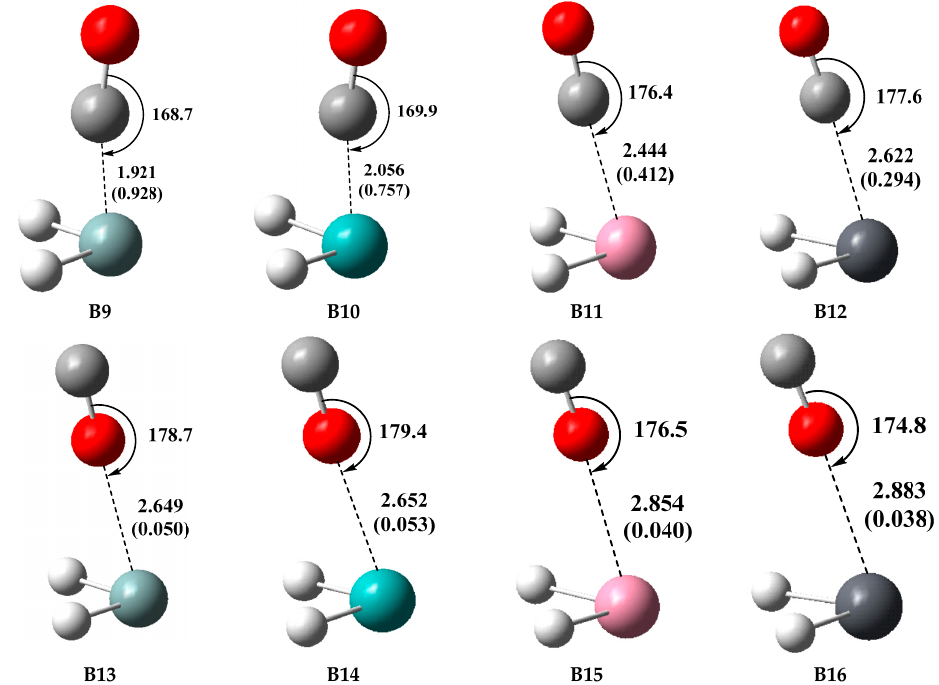
Figure 9. Optimized geometries of the type-B complexes involving CO at the MP2/aug-cc-pVDZ level, distances in Å, angles in °, and WBI values (in parenthesis).